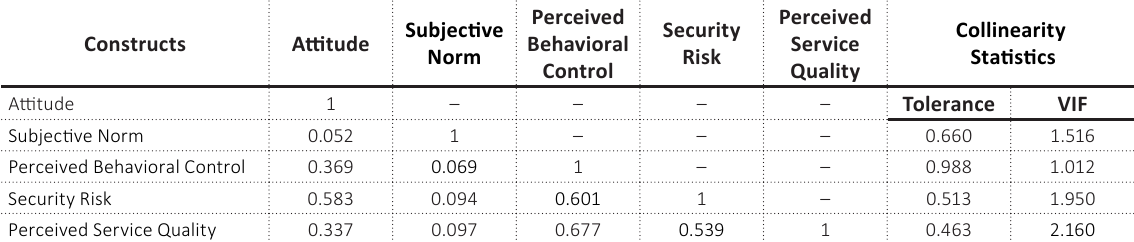
Table 3. Correlation and collinearity statistics